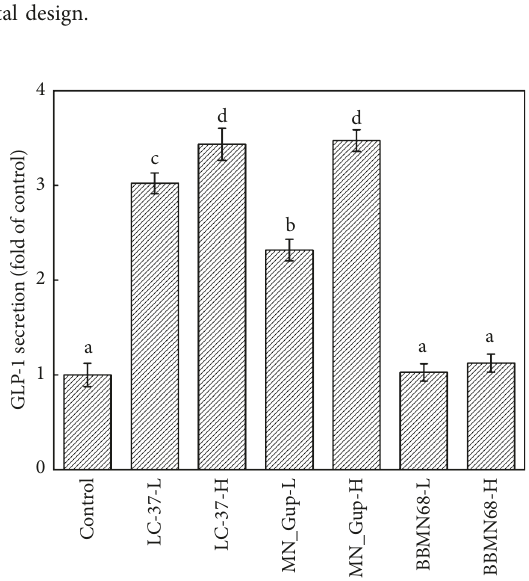
Figure 2: Effects of three probiotic strains on GLP-1 secretion in NCI-H716 cells at low (5 × 10 9 CFU/mL) and high (5 × 10 10 CFU/ mL) doses. Control group is incubated with PBS. Data are shown as means ± standard deviations (SD), and different lowercase letters indicate significant differences, p < 0 . 05 ( n �